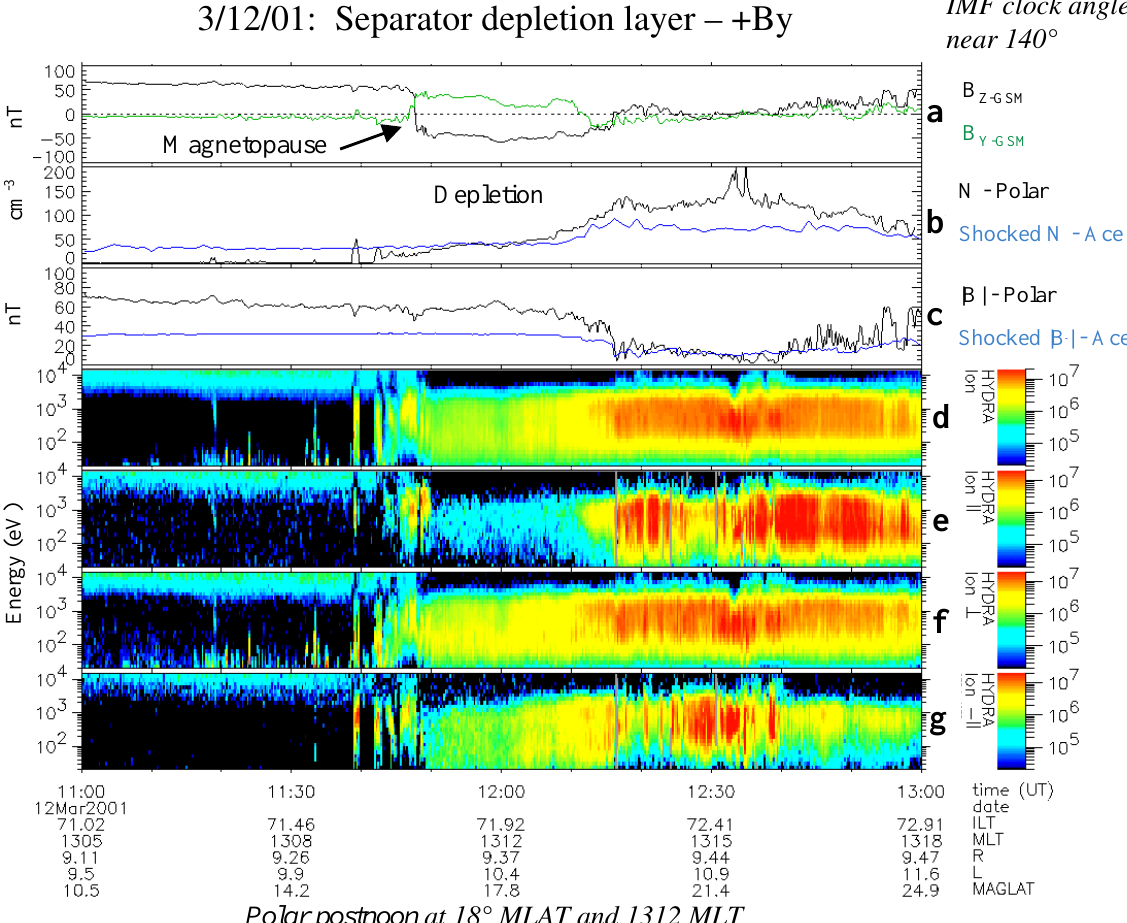
Fig. 2. Example of a depletion layer for negative B Z and positive B Y in the same format as Fig. 1. Polar was located at 18 ◦ MLAT and 13:12